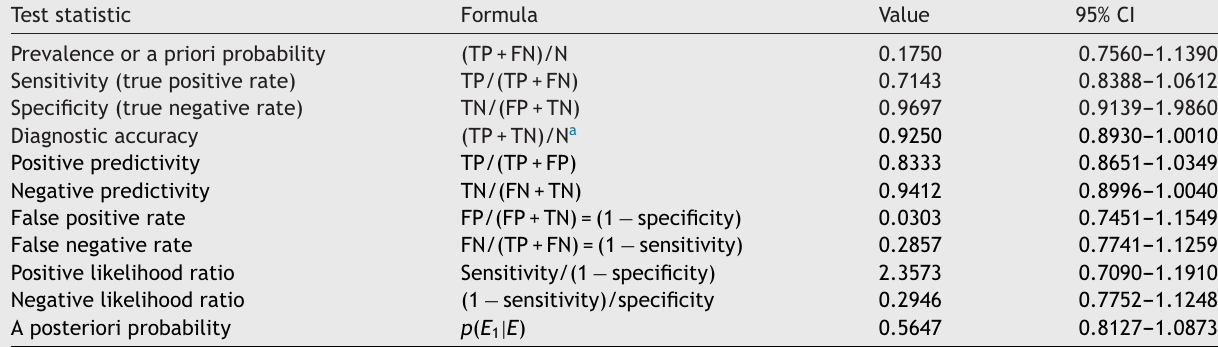
Computed probability values of different Bayesian test statistics of diagnosis of thyroid